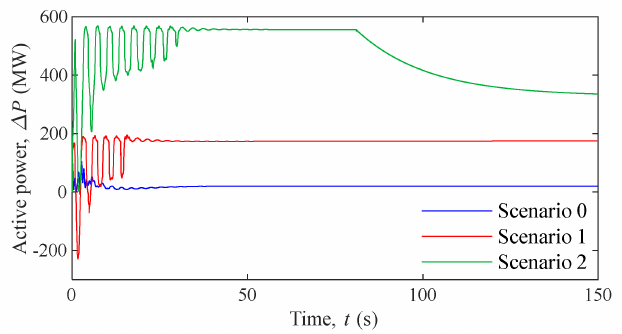
Figure 14. Frequency response after inserting a frequency disturbance of ∆ P = 1300MW at t = 0 s, with a total kinetic energy of 105 GW.s.